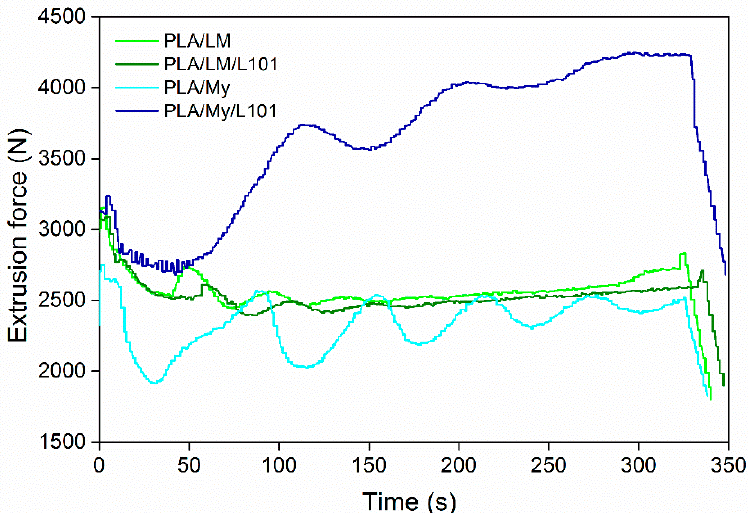
Figure 1. Typical evolution of the extrusion force as a function of the extrusion time, time origin corresponding to the injection of liquid (plasticizer with or without the radical initiator) to polylactide (PLA) already present in the micro-compounder.